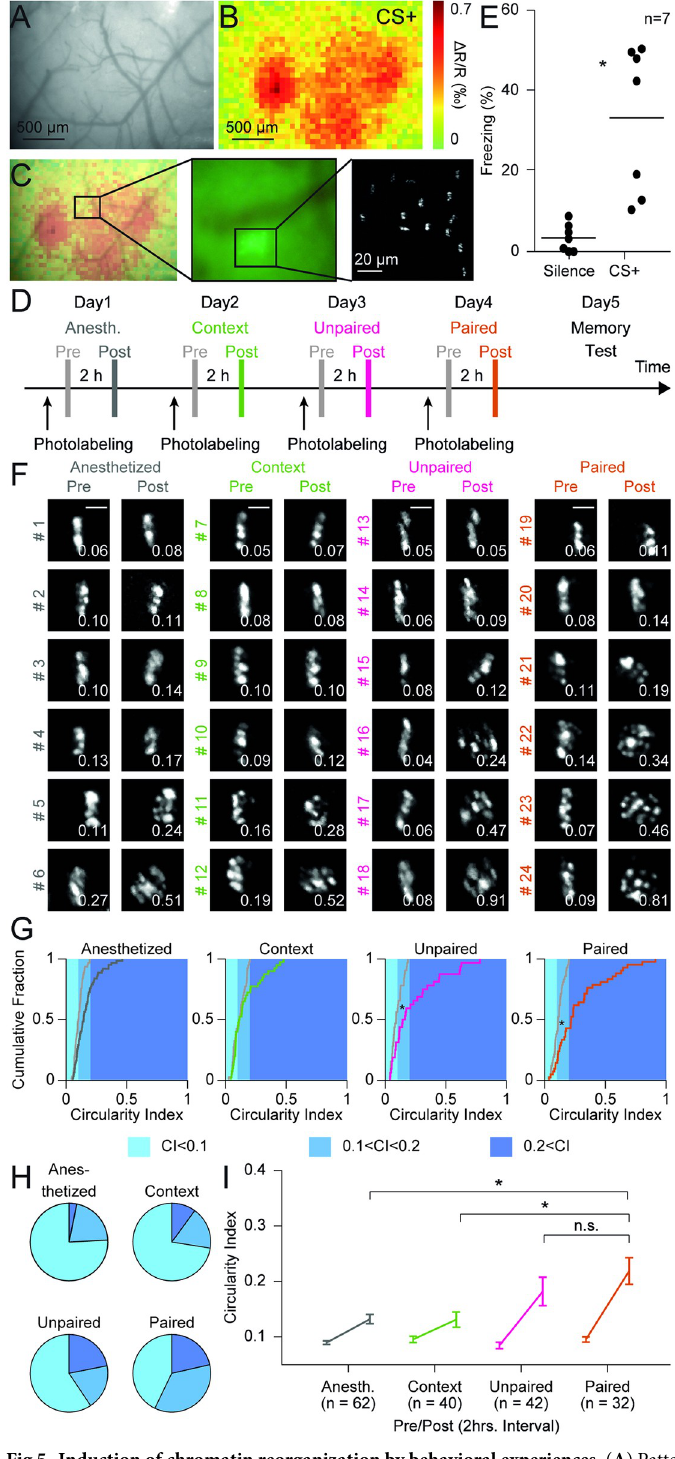
Fig 5. Induction of chromatin reorganization by behavioral experiences. ( A ) Pattern of surface vessels over the auditory cortex as seen through a cranial window. ( B ) Same field of view displaying intrinsic signals indicating metabolic activation by a sound used as conditioned stimulus (CS+) for auditory cued fear conditioning. ( C ) Left: Overlay of vessel pattern and intrinsic optical signals. Middle: Epifluorescence image with shadows of surface vessels and field of photolabeled neurons. Right: Labeled neurons in a two-photon image of layers II/III. ( D ) Schematic of the